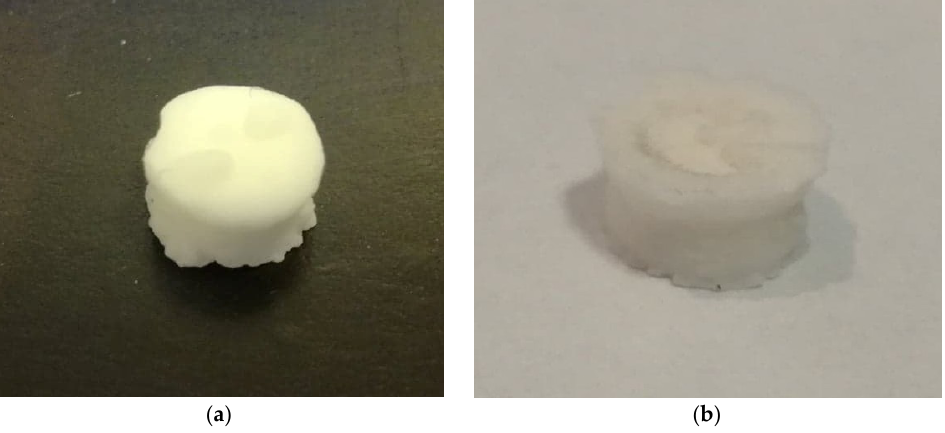
Figure 6. Samples made of IHDENT Giz type II ionomer glass cement removed from the soda solution after ( a ) 7 days and ( b ) 30 days.